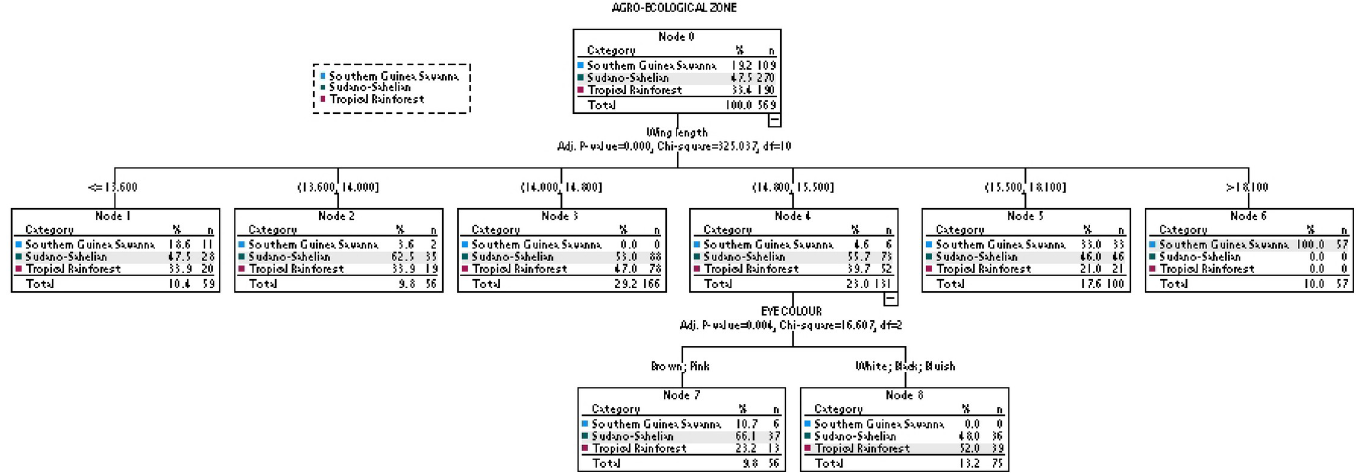
Fig 5. Association between the agro-ecologies and the phenotypic traits using CHAID.